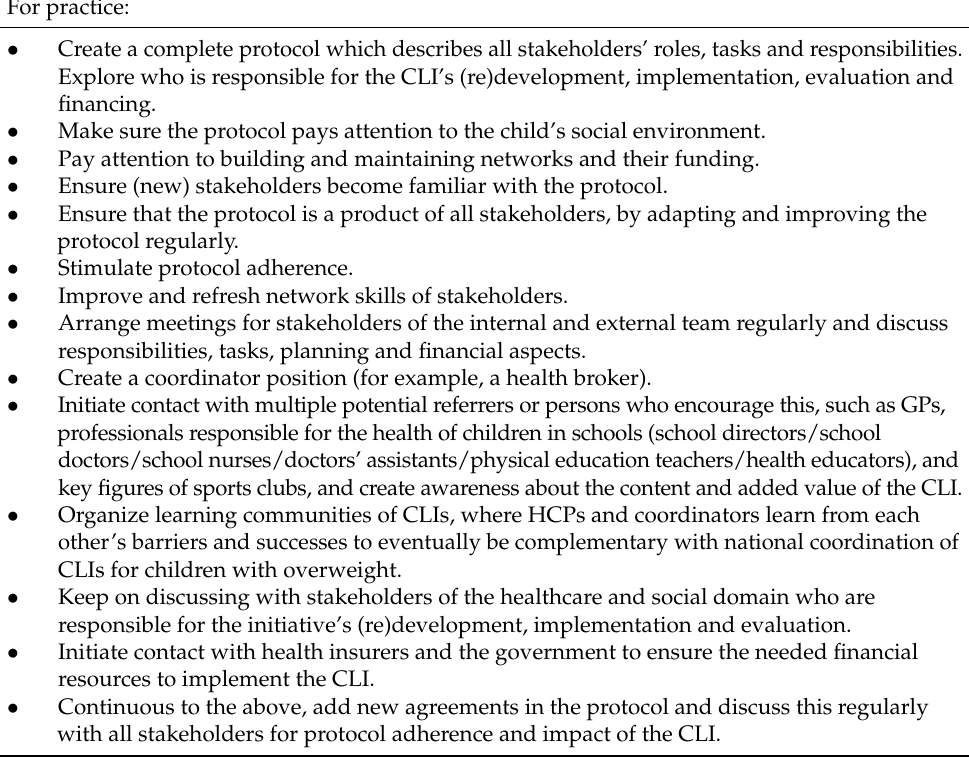
Table 3. Recommendations. Overview of recommendations for practice and future